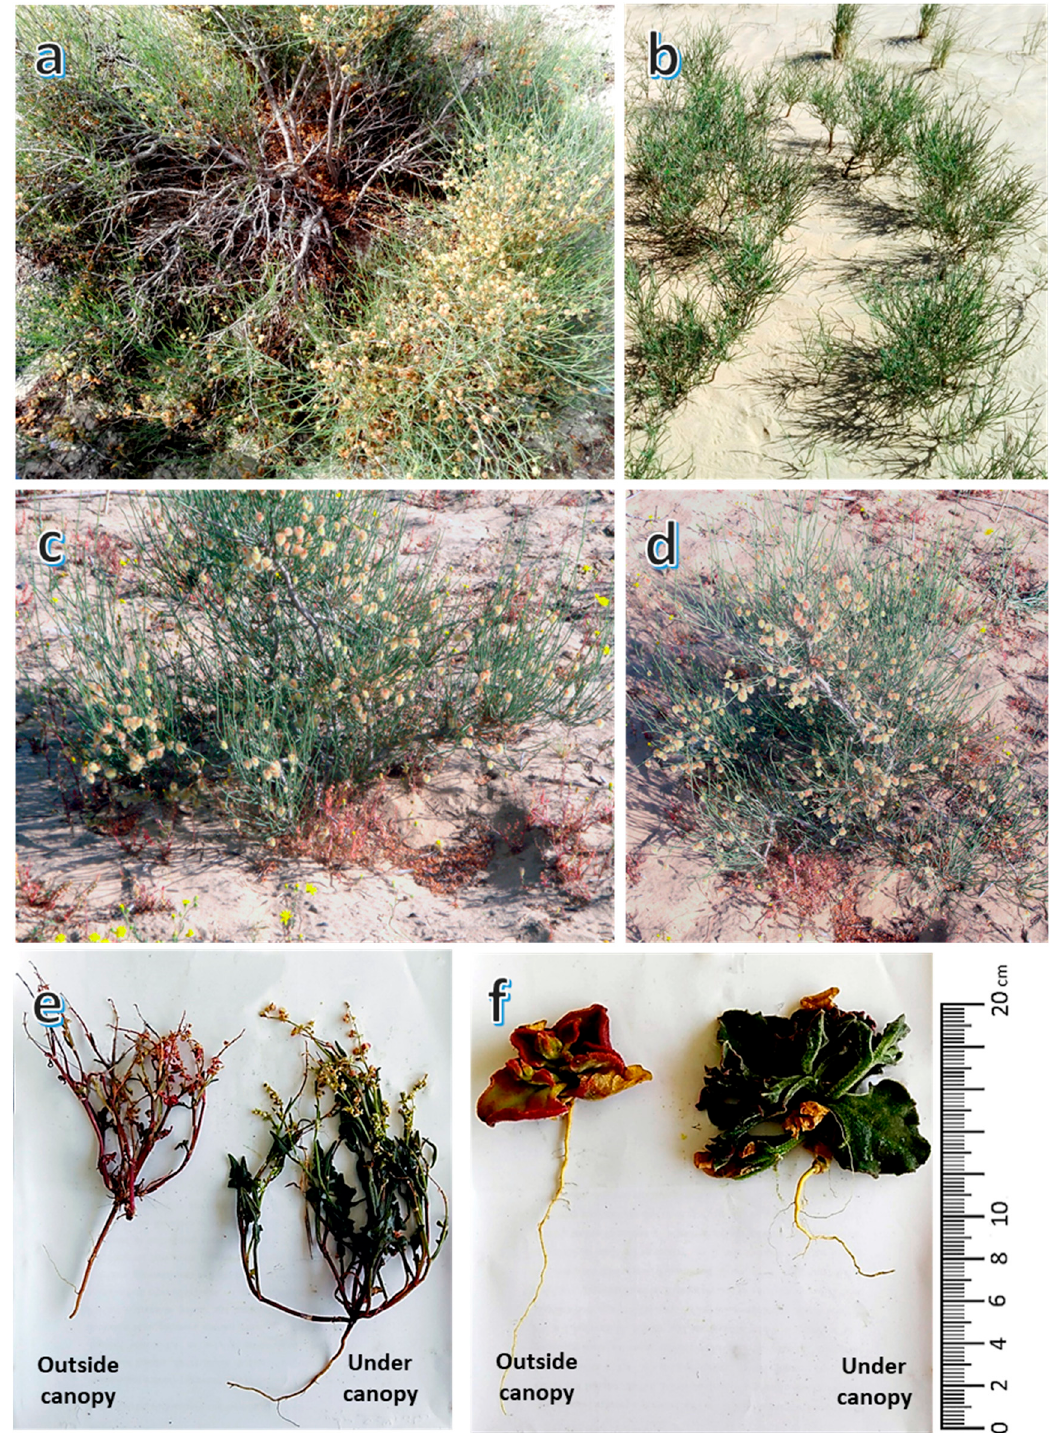
Figure 1. Calligonum polygonoides L. shrub and two selected understory species. ( a ) overview of old shrub, ( b ) regenerated vegetative branches, ( c , d ) young shrub, ( e ) Rumex pictus L. under, and outside the canopy of C. polygonoides , and ( f ) Mesembryanthemum crystallinum L.